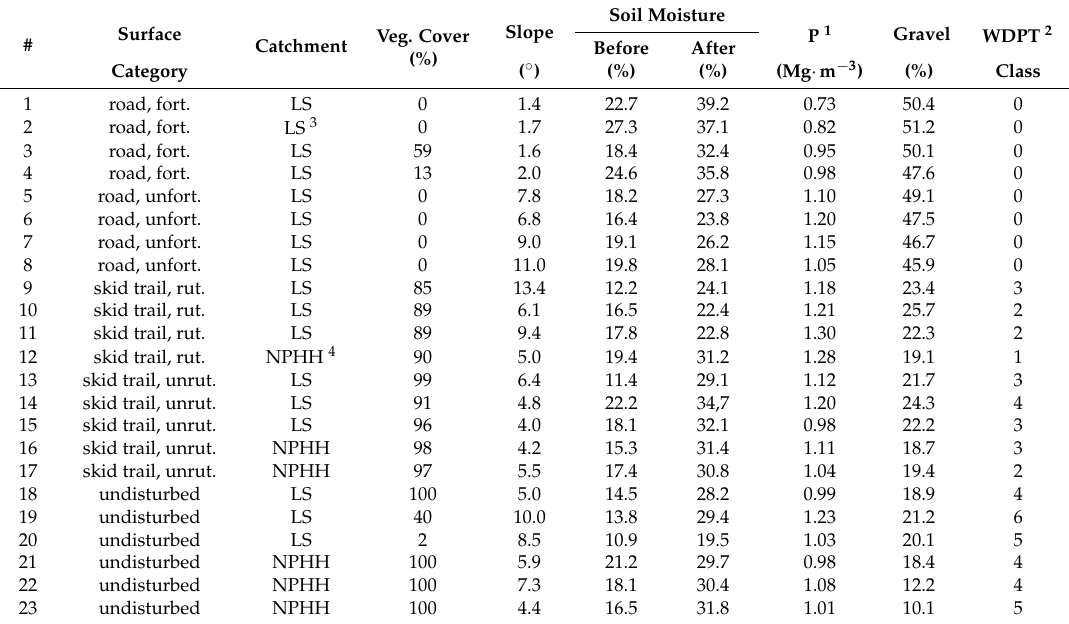
Table 3. Plot characteristics for all conducted